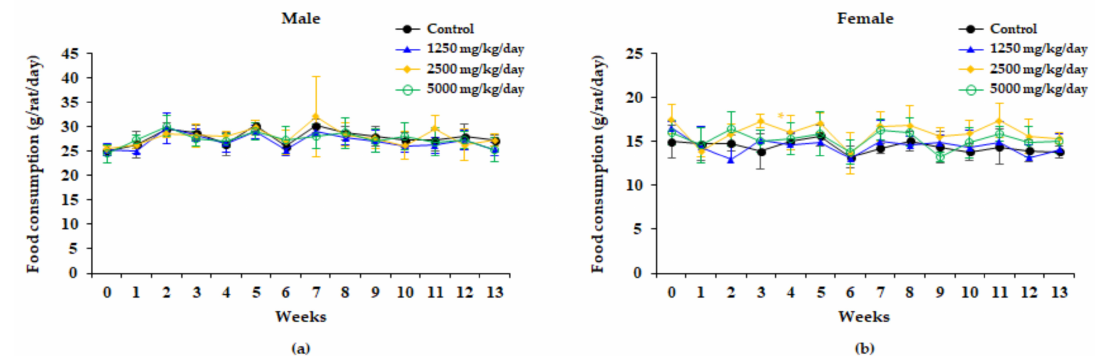
Figure 2. Food consumption of male ( a ) and female ( b ) rats treated with 0, 1250, 2500, and 5000 mg/kg/day in the 13 weeks repeated oral dose toxicity study of WG extract. Results are presented as the mean ± standard deviation (n = 10). Significantly different from the control group at * P <